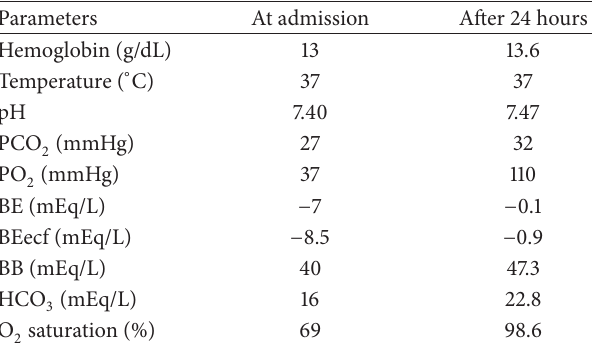
Table 1: Results of the arterial blood gas analysis of the patient at admission and after 24